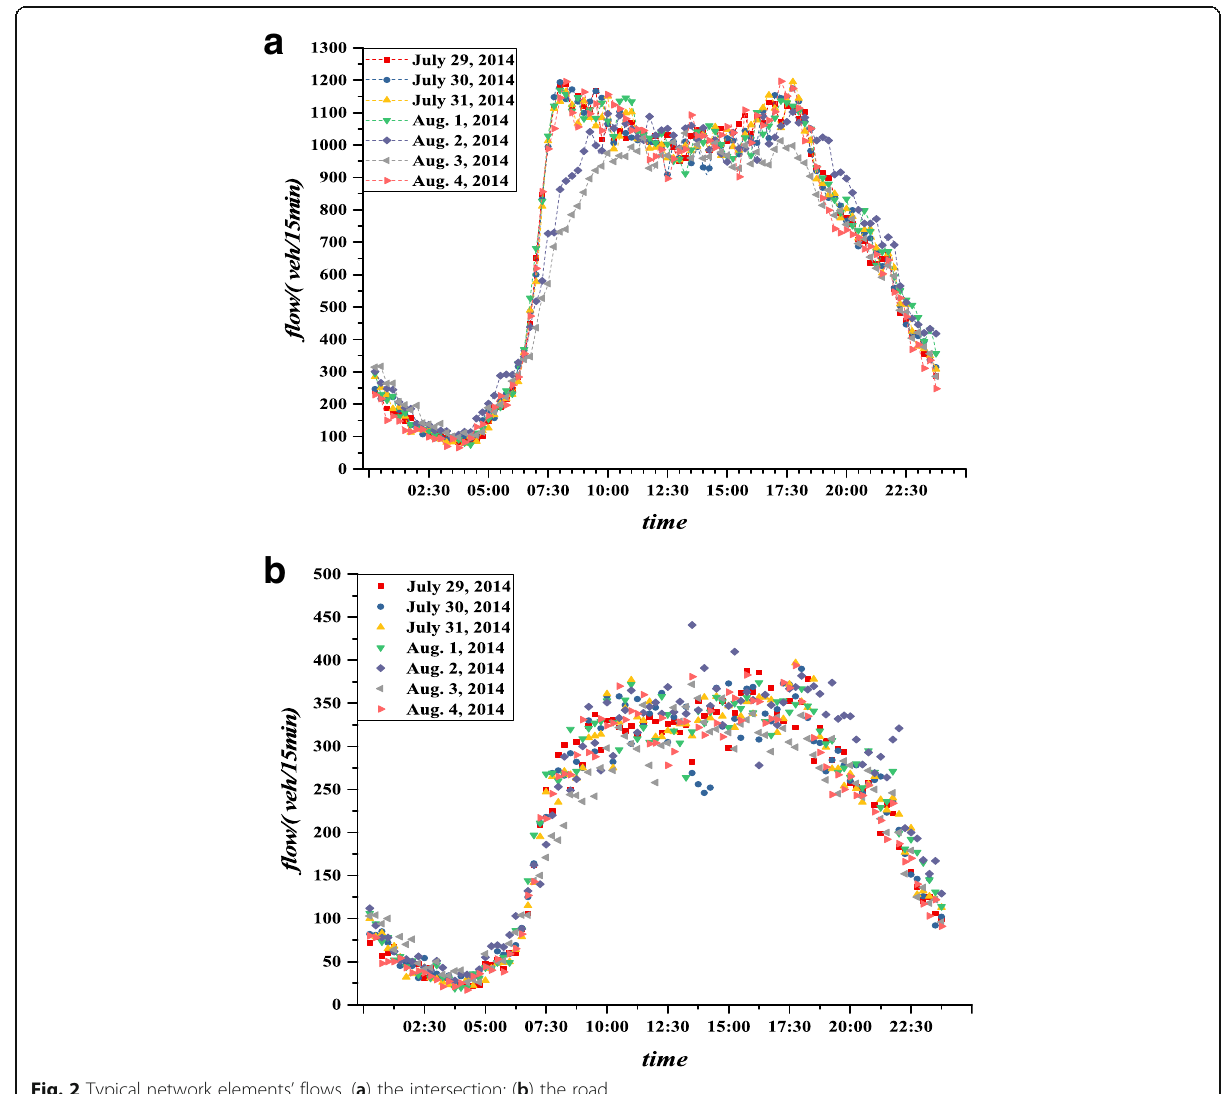
Fig. 2 Typical network elements ’ flows, ( a ) the intersection; ( b ) the road